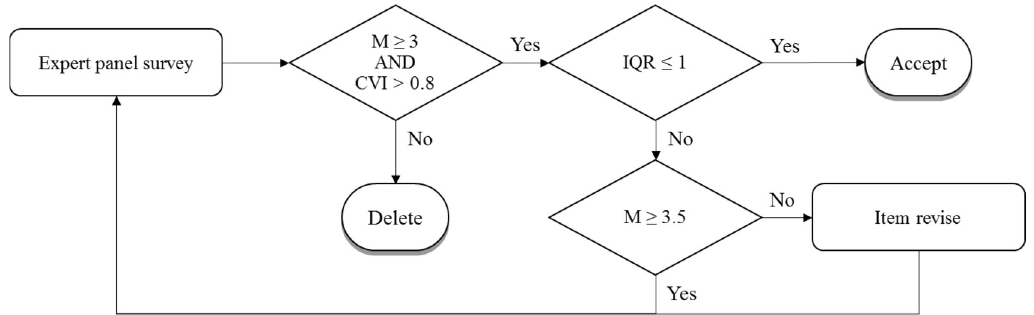
Fig 1. Criteria and flow for expert panel method. M , Mean; IQR , Interquartile